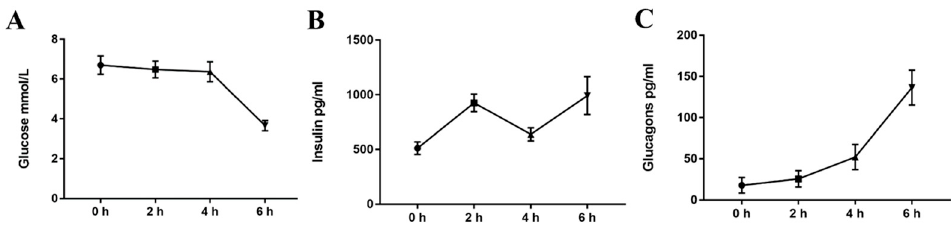
Figure 2. Effect of acute cold exposure on the level of ( A ) glucose, ( B ) insulin, and ( C ) glucagon in C57BL/6 mouse plasma. The data are presented as the mean ± standard error of the mean (SEM) ( n = 8). Statistically significant differences are indicated; * p < 0.05 and ** p < 0.01.